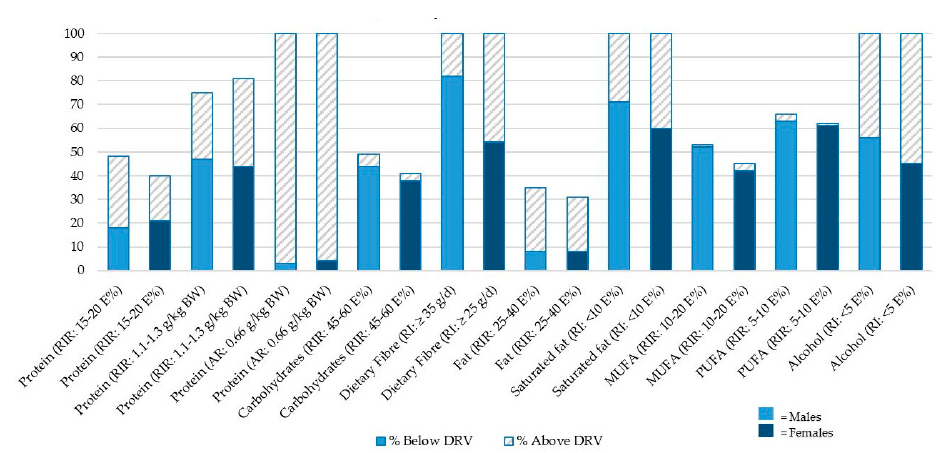
Figure 1. Percentage of study participants with intakes of macronutrients, dietary fiber and alcohol below and above respective DRVs. For nutrients with DRVs given as intervals, the figure